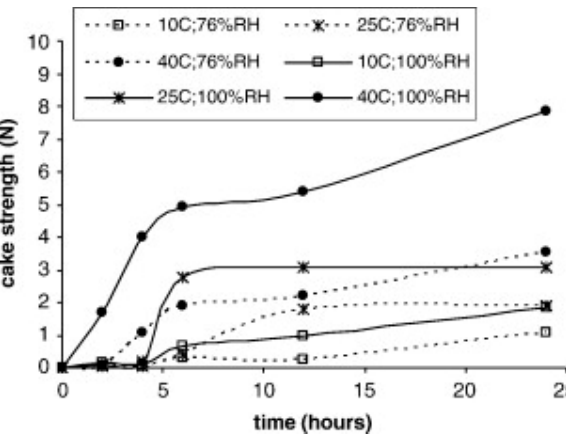
Figure 6 . Effect of temperature, relative humidity (RH) and exposure time on the cake strength of skim milk powder. Source: Fitzpatrick et al., [101] .